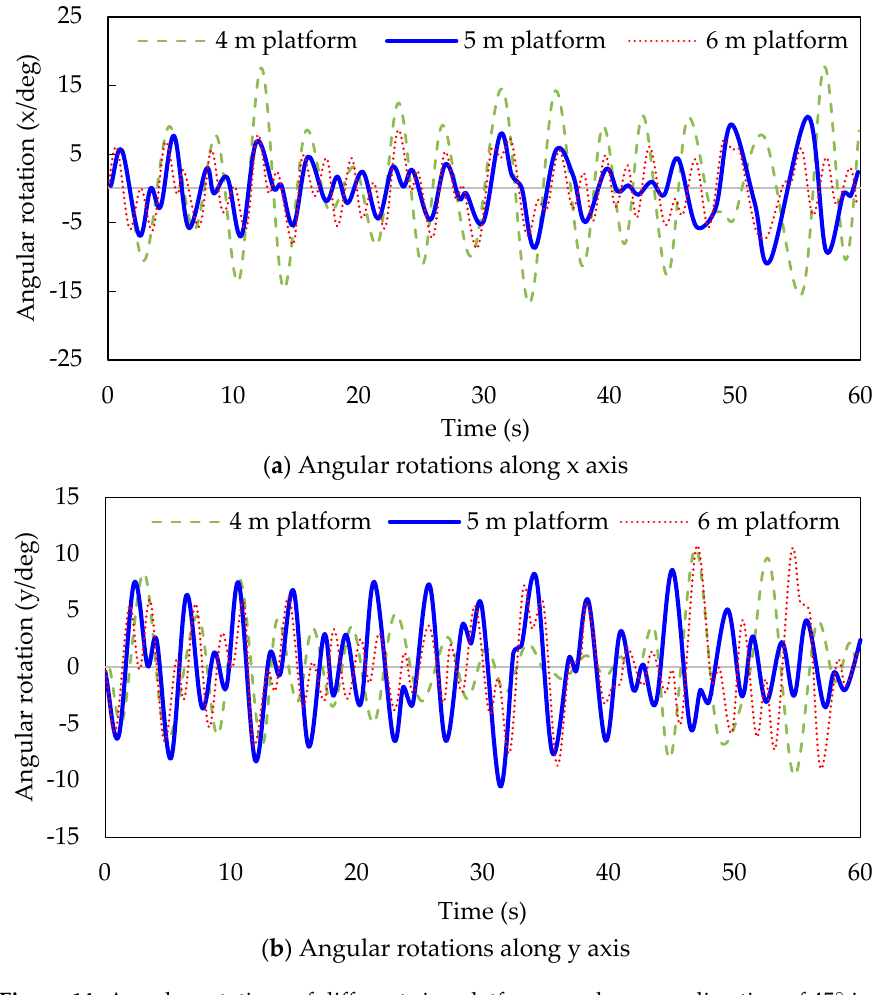
Figure 14. Angular rotations of different size platforms under wave direction of 45° in wind − sea scale 4.